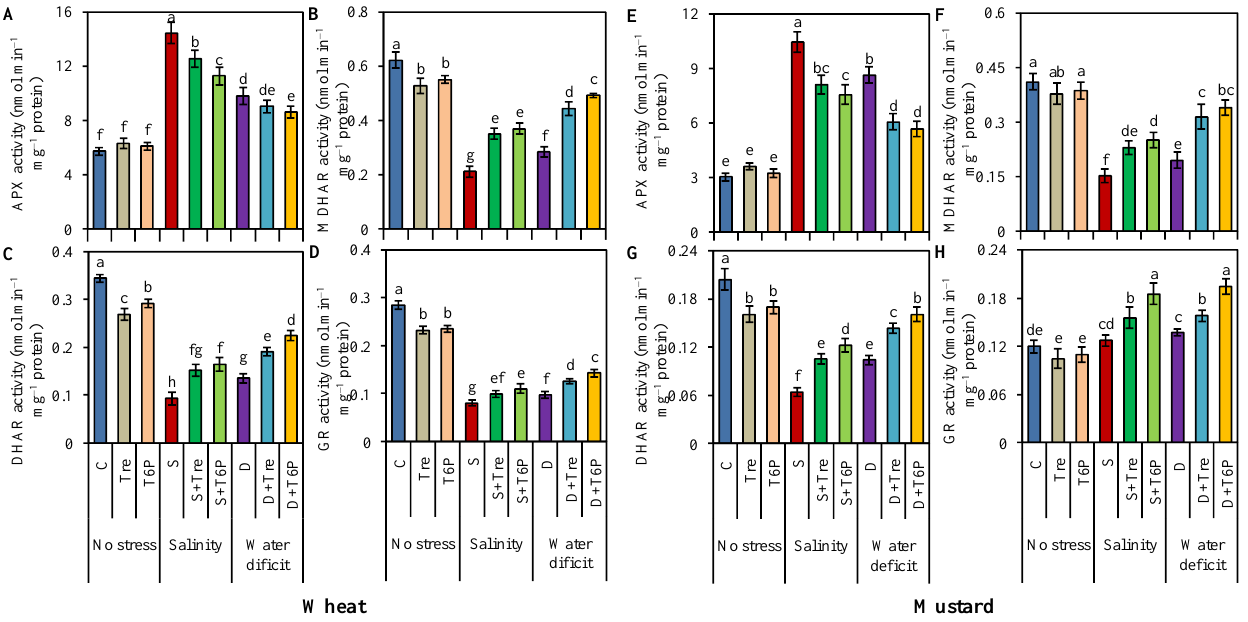
Figure 6. Effect of trehalose and T6P on the activities of APX, MDHAR, DHAR, and GR in wheat and mustard seedlings. Wheat seedlings were grown in a hydroponic solution containing 300 mM NaCl for 9 days. Mustard seedlings were grown in 200 mM NaCl for 10 days. For water deficit treatment, wheat seedlings were treated with 20% PEG, while mustard was treated with 12% PEG for four days. C, control; ( A – D ) wheat; ( E – H ) mustard; Tre, 200 µM trehalose; T6P, 200 µM trehalose 6-phosphate; S, NaCl treatment; D, water deficit treatment with PEG 6000. Means were calculated from three replicates for each treatment, and the bars represent the standard deviation (±SD). Values with different letters are significantly different at p ≤ 0.05 by Fisher’s LSD test.